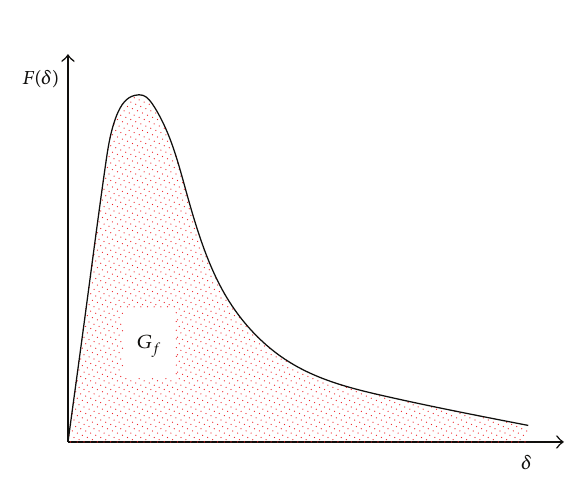
Figure 2: Expression of fracture energy.